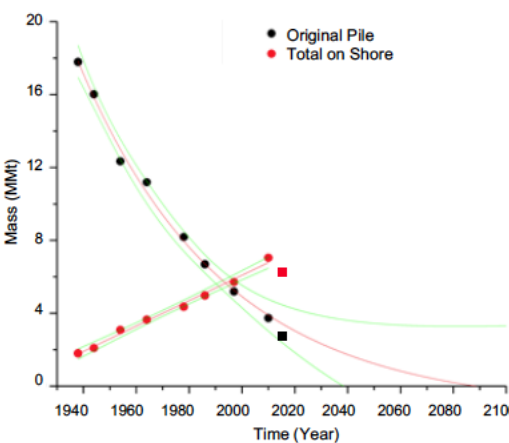
Figure 8. Erosion from the Gay tailings pile through time (mass remaining, black dots) and accumulation of redeposited stamp sand along the beach margin (total mass, red dots). Mass is in million metric tons (MMt). Green bands indicate 95% C.L. around regressions. Up to 2010, erosion of the tailings pile closely followed an exponential loss function, whereas accumulation on beaches originally fit a linear increase. Recent (2008–2016, squares) measurements suggest shoreline deposition is declining.